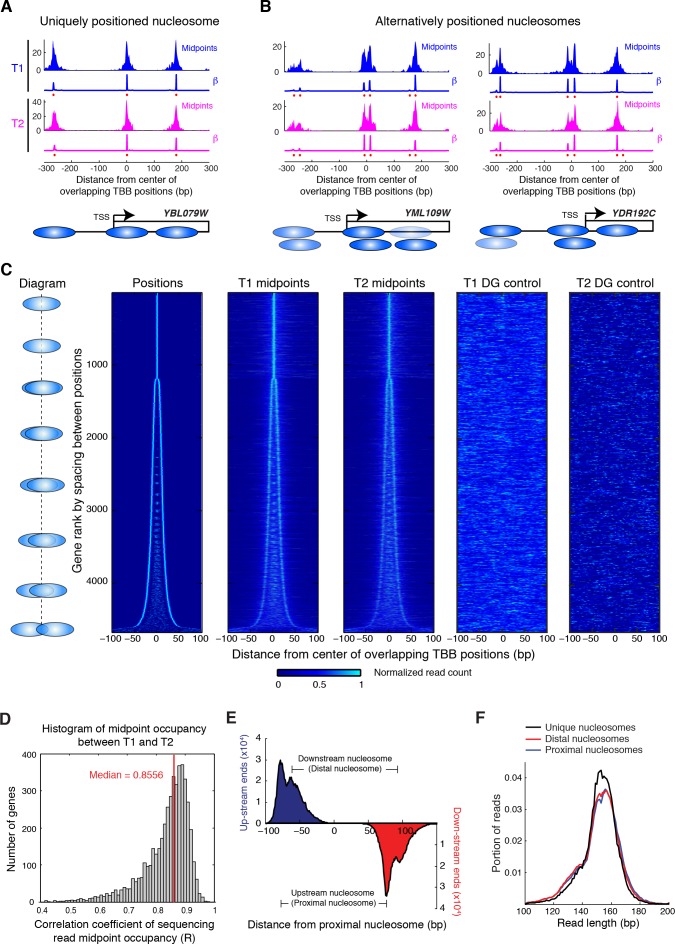
Alternatively positioned nucleosomes at transcription start sites.(A,B) Examples of a uniquely positioned nucleosome (A), and alternatively positioned nucleosomes at the TSS (B). Blue and magenta traces show the sequencing read midpoint occupancy and fitted coefficient β from experiments ‘T1’ and ‘T2’, respectively. Ovals indicate the TBB nucleosome positions and are colored based on coefficients β. (C) Heat map showing the TBB nucleosome positions ('Positions'), the occupancy of read midpoints from two experiments (T1 and T2), and the occupancy of read midpoints from the two MNase bias simulations ('T1 DG control' and 'T2 DG control'). All data are aligned by the centers of selected unique or alternative nucleosome positions (essentially the consensus center of +1 nucleosomes) that overlap with the transcription start site (TSS) (4672 open reading frame in total). The order of transcripts is ranked by the maximum space between TBB nucleosome positions within each group, as illustrated by the diagrams on the left. The positive direction of the x-axis indicates 5’ to 3’ for all transcripts. (D) Correlation coefficient of the sequencing read midpoint occupancy (un-smoothed) in experiment T1 and T2 for each gene in panel C. (E) Graph showing the end location of paired-end sequencing reads of the upstream and downstream nucleosomes in panel C (later defined as the proximal and distal nucleosomes, respectively). The ends are aligned at the position of upstream nucleosomes (proximal nucleosomes). (F) Length distribution of paired-end sequencing reads in the unique, proximal and distal nucleosomes at gene promoters. In both (E) and (F), if the midpoint of a sequencing read is within 5 bp of the position of a nucleosome, it is counted as a read of this nucleosome.DOI:
http://dx.doi.org/10.7554/eLife.16970.01910.7554/eLife.16970.020Figure 5—source data 1.Source data for Figure 5C, with arrays of positions, midpoints from T1 and T2 used for generating the graph.